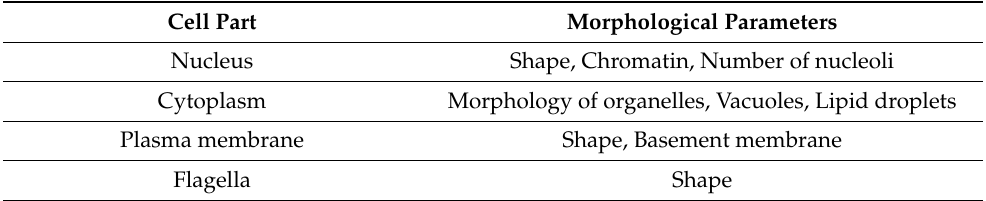
Table 1. Morphological parameters considered in the cell